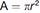
Rab21 regulates the amoebic actin dots.
A. Trophozoites stably expressing HA tagged Rab21WT, Rab21CA and Rab21DN were harvested and plated on uncoated glass surface, fixed and stained using anti HA, followed by secondary anti mouse Alexa488 and Alexa568 Phalloidin and z stacks were acquired (z step = 1μm). A representative slice from the z stack is shown. Scale bar, 10μm. B. Quantification of number of actin dots formed in Rab21WT and CA, DN mutants when plated on glass or FN coated (100μg/ml) coverslips (n = 150cells). Graph shows mean ± SEM of three independent experiments. **, P<0.01.C.Trophozoites stably expressing HA tagged Rab21CA were harvested and plated on glass and collagen type I (100μg/ml) coated surface and incubated for an hour at 37°C. Cells were fixed and stained for actin using Alexa568 Phalloidin and z stacks were acquired for every z step of 1μm. A representative slice from the z stack is shown. Scale bar, 10μm. D. Quantification of the mean area of actin dots formed in the Rab21CA mutant plated on collagen type I (100μg/ml) coated surface. Mean area was calculated for n = 180 actin dots for collagen type I and n = 145 actin dots for glass surface. Mean diameter was manually measured using the motion tracking software and area calculated, treating the actin dot to be a circular object (Α=πr2) and plotted using GraphPad Prism5. Graph shows mean ± SEM.***, P<0.001. E. Trophozoites transfected with Rab21CA were placed between two layers of either Matrigel at 1mg/ml or collagen type I at 2mg/ml and incubated for 6–8hrs at 37°C. Trophozoites transfected with empty vector were also sandwiched between matrigel as control. Samples were fixed and processed for SEM and imaged using Zeiss Ultra PLUS. Left panel shows lower magnification micrographs (1000X for matrigel, scale bar 10μm and 500X for collagen type I, scale bar 20μm) while the right panel shows higher magnification micrographs (8000X, scale bar 2μm).Arrows indicate surface protrusions produced on Rab21CA cells in a matrigel sandwich compared to the rough surface in a collagen type I sandwich.